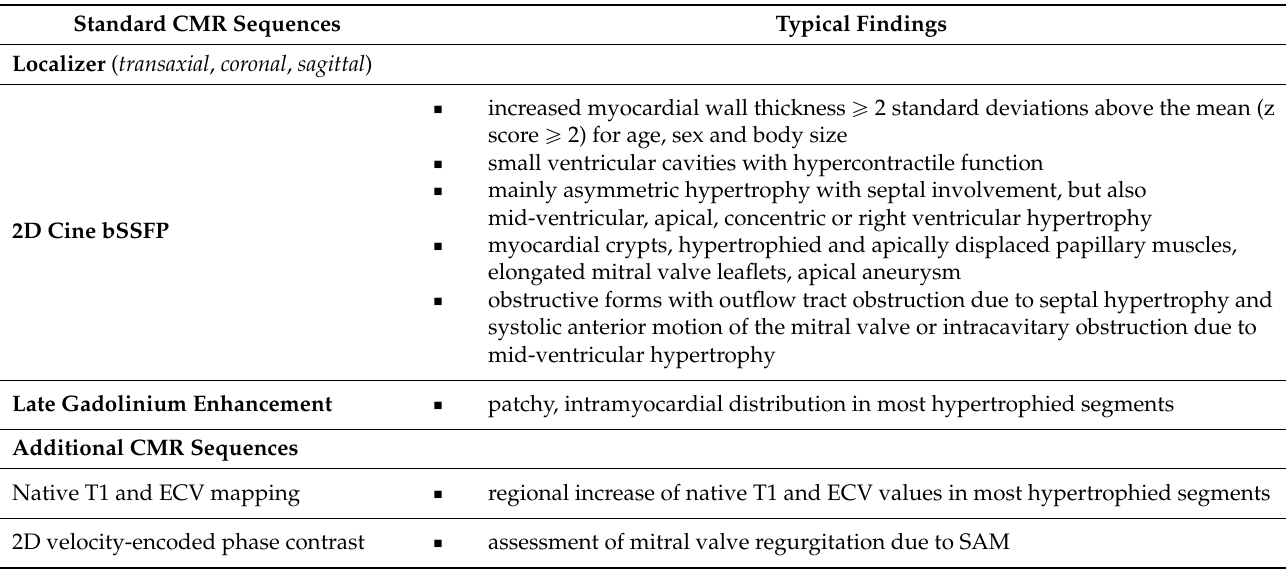
Table 2. Standard and additional CMR sequences for assessment of HCM in